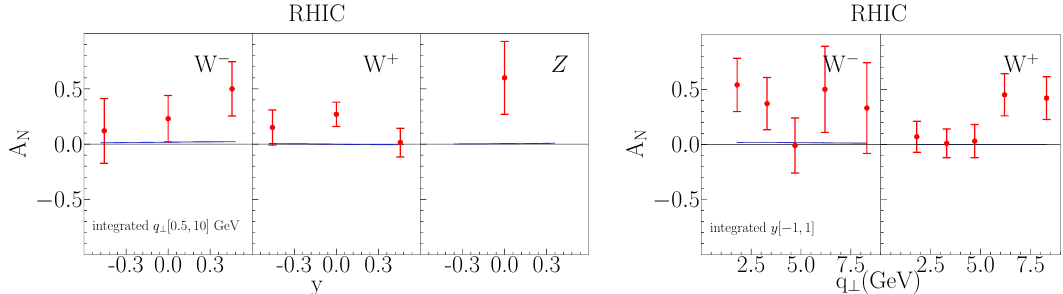
√ S = 500 GeV [47] using